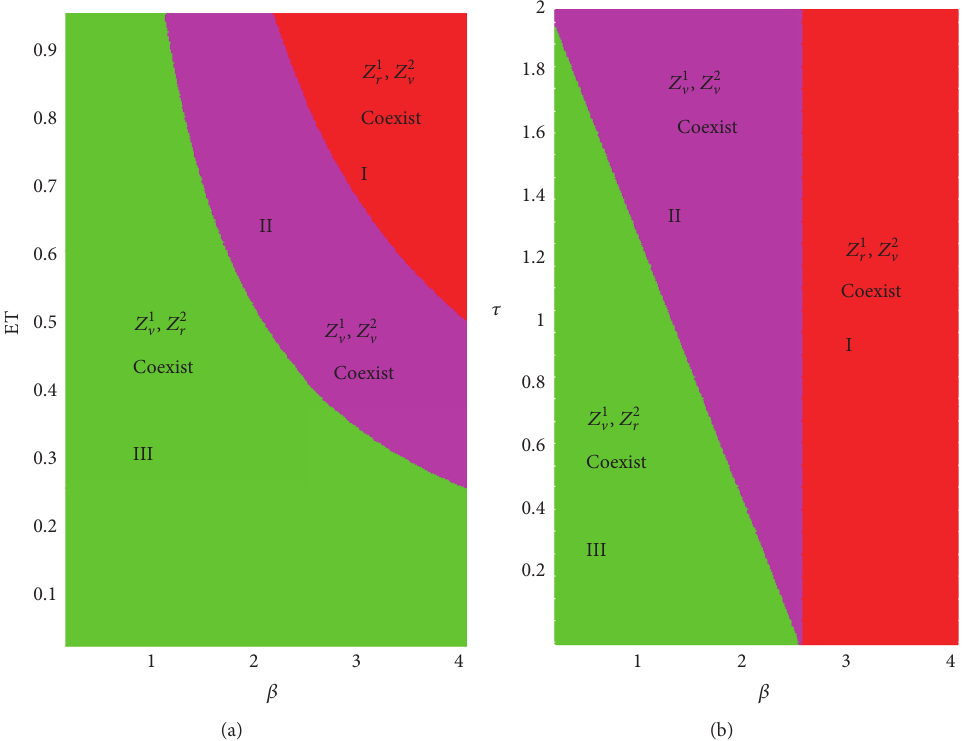
Figure 2: Parameter bifurcation diagram for the existence of equilibria of system (6). Region I (red): 𝑍 1 𝑟 and 𝑍 2 V coexist. Region II (purple): 𝑍 2 𝑍 1 V and V coexist. Region III (green): with ET = 0.8 and 𝛿 = 2.